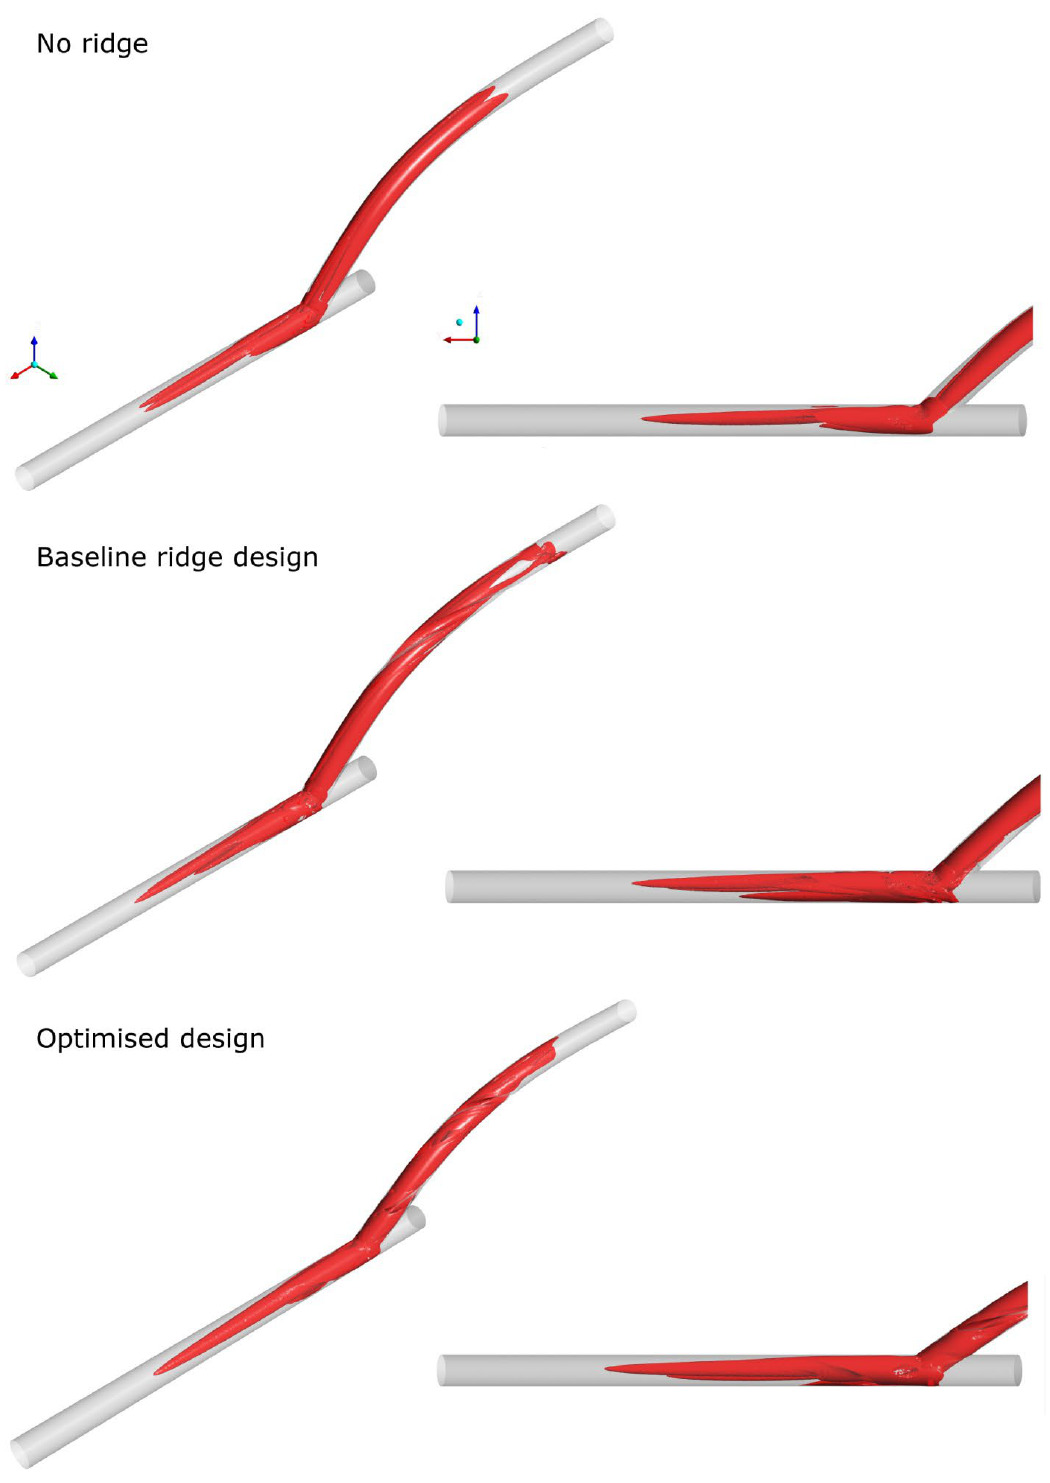
Figure 6. Helicity isosurfaces for the reference, baseline ridge design, and optimised design of the current work.